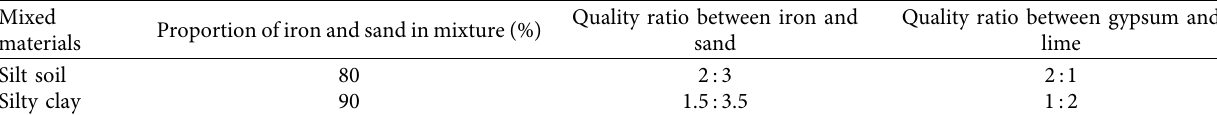
Figure 7: Proportion of mixed materials. Table 12: Mixed material proportion table.